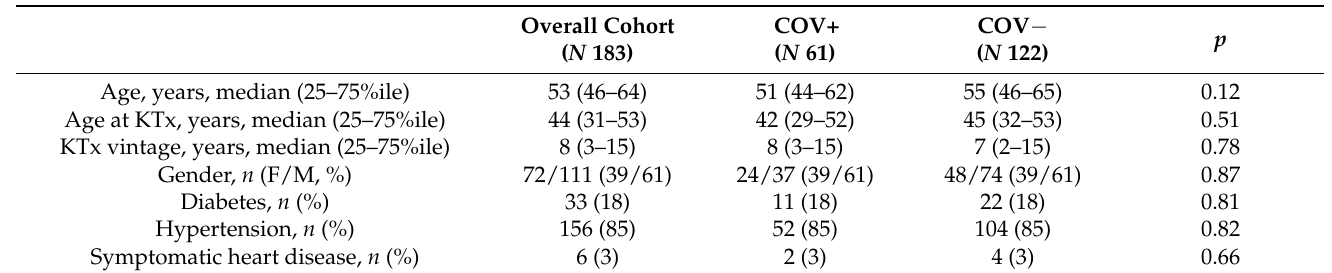
Table 1. General features of the studied patients considered globally and according to COV status (COV+ and COV − ).